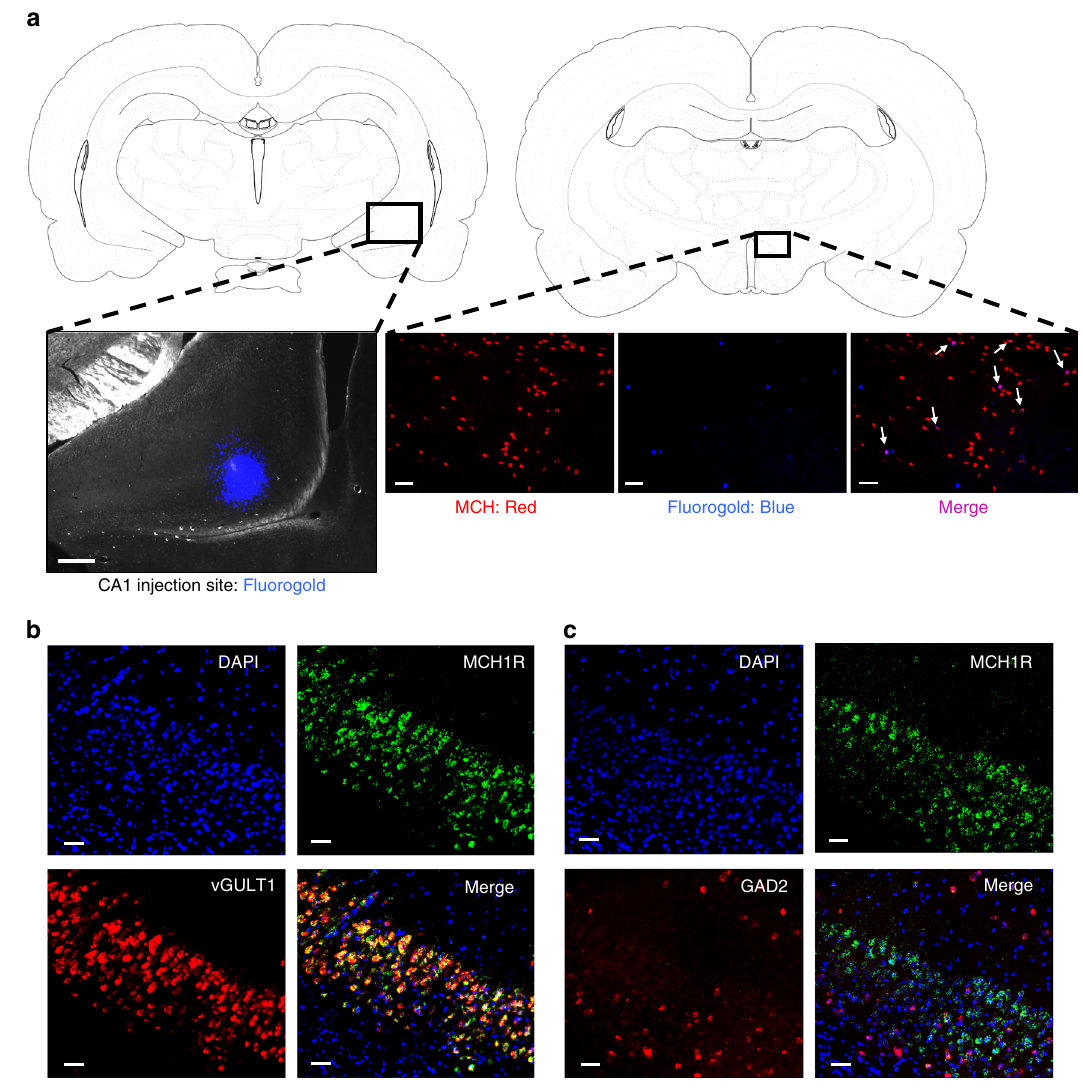
Fig. 2 MCH neurons communicate to glutamatergic neurons in the CA1v. a (left) A representative injection site for fl uorogold in the CA1 region of the vHP; scale = 200 µ m. (right) Fluorogold (pseudocolored blue) colocalizes with MCH immuno fl uorescence (red) in a region of the lateral hypothalamic area (white arrows indicate colocalization); scale = 100 µ m. b Fluorescence in situ hybridization for MCHR1 mRNA (green) and the glutamatergic marker vGLUT1 (red), with DAPI counterstain (blue). c Fluorescence in situ hybridization for MCHR1 mRNA (green) and the GABAergic marker GAD2 (red), with DAPI counterstain (blue); scale = 50 µ